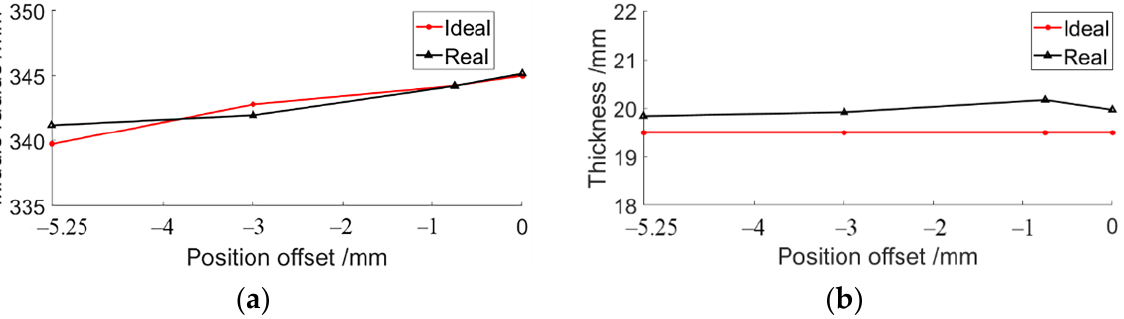
Figure 15. The influence of the rollers’ offset position on the final tube shape: ( a ) Middle radius; ( b )